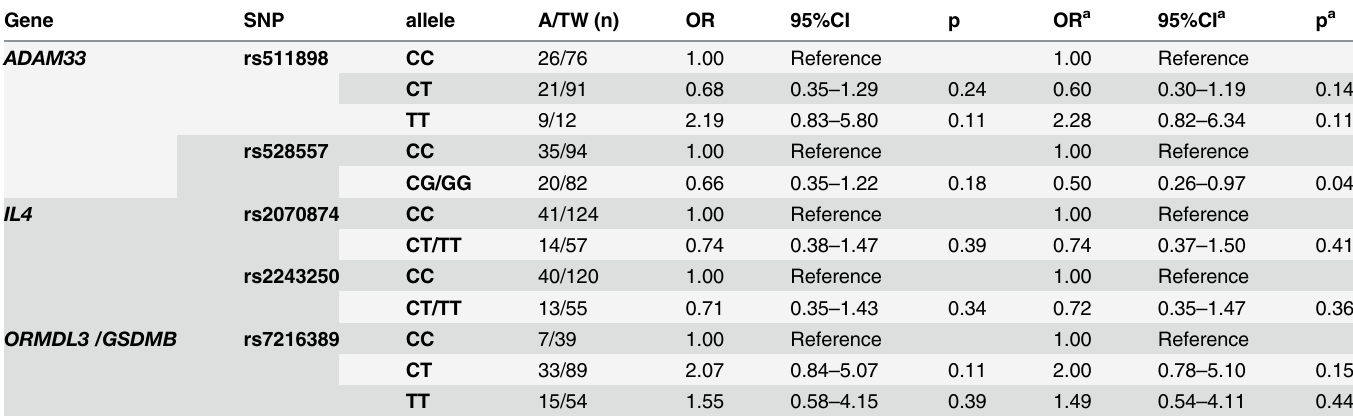
Table 3. Replication of associated genetic variants in the KOALA Birth Cohort Study.